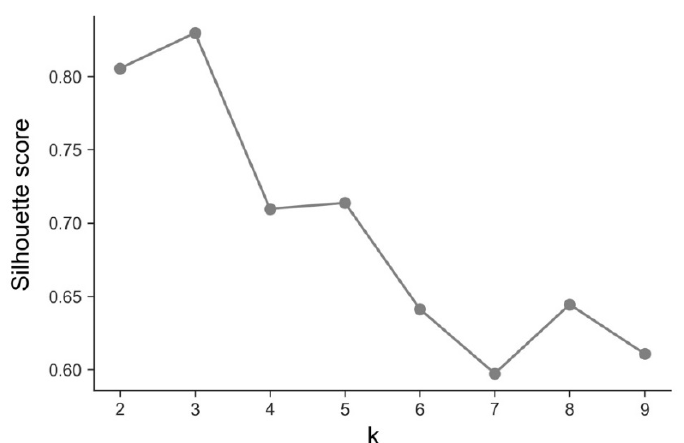
Figure 3. Silhouette score for countries temporal clustering of COVID-19 deaths by 100,000 of the population (k = number of clusters). population (k = number of